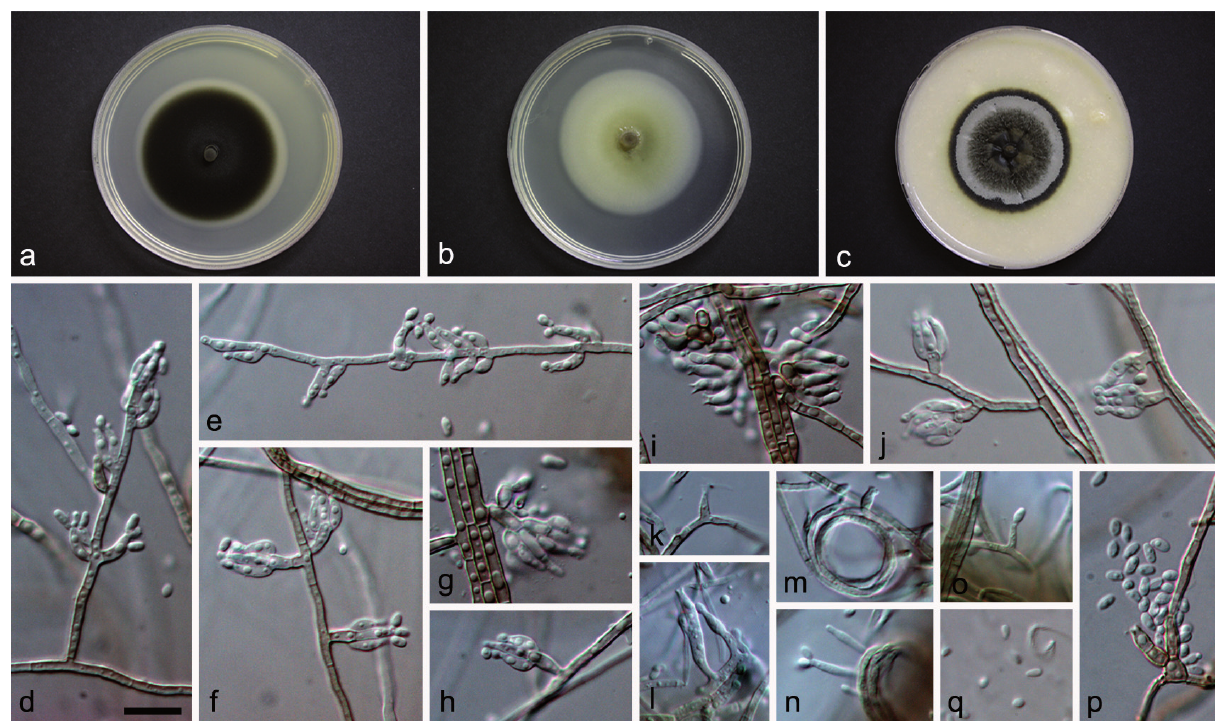
Figure 4. Cadophora melinii . a–c. Sixteen-day-old colonies on MEA (a), PDA (b) and OA (c). d-p. Aerial structures on MEA; d-p, conidiophores and phialides; q. conidia. Scale bar: d–q=10 µ m. Scale bar for d also applies to